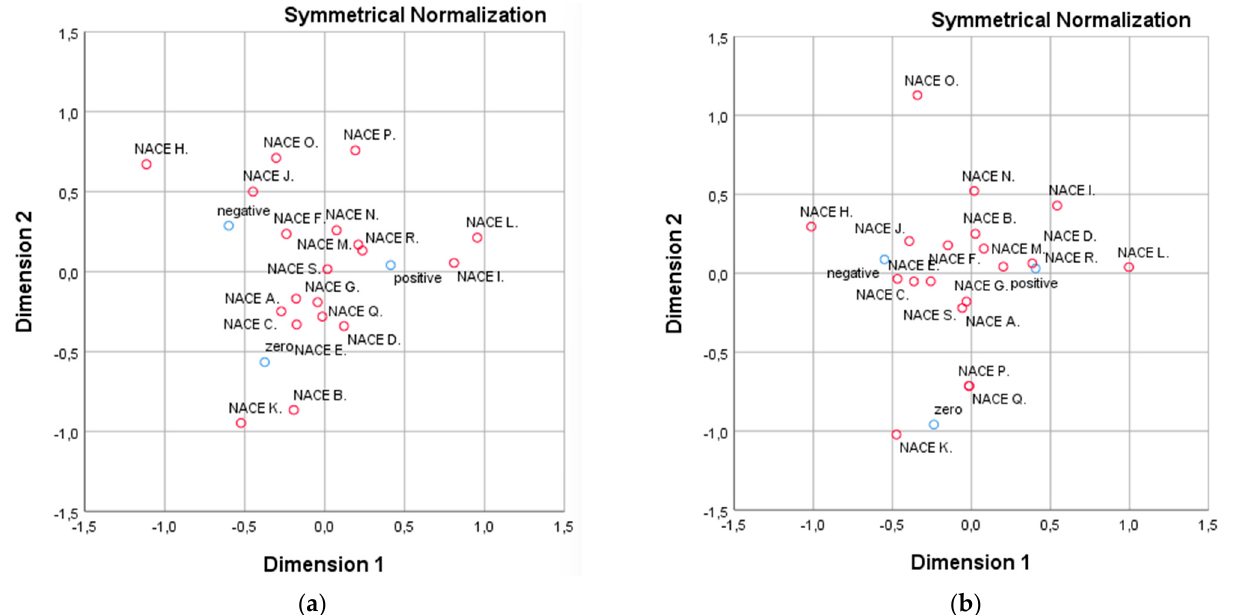
Figure 2. Correspondence map: ( a ) 2017/2018; ( b ) 2018/2019.